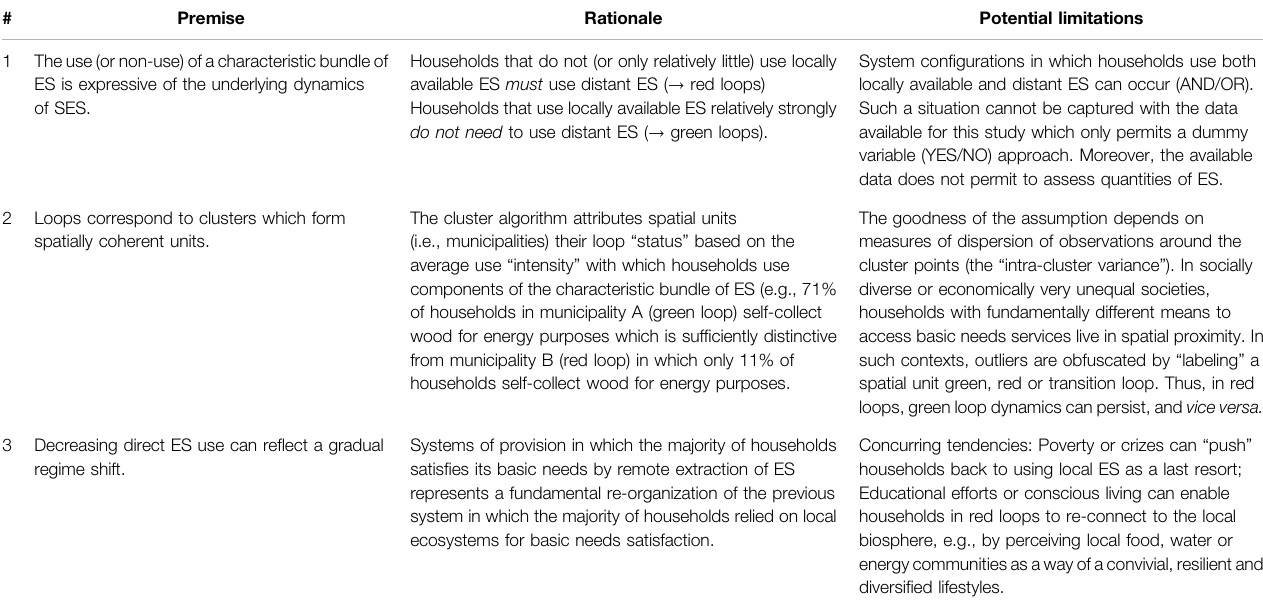
TABLE 2 | Main premises of the methodological approach, including their rationale and potential limitations. #